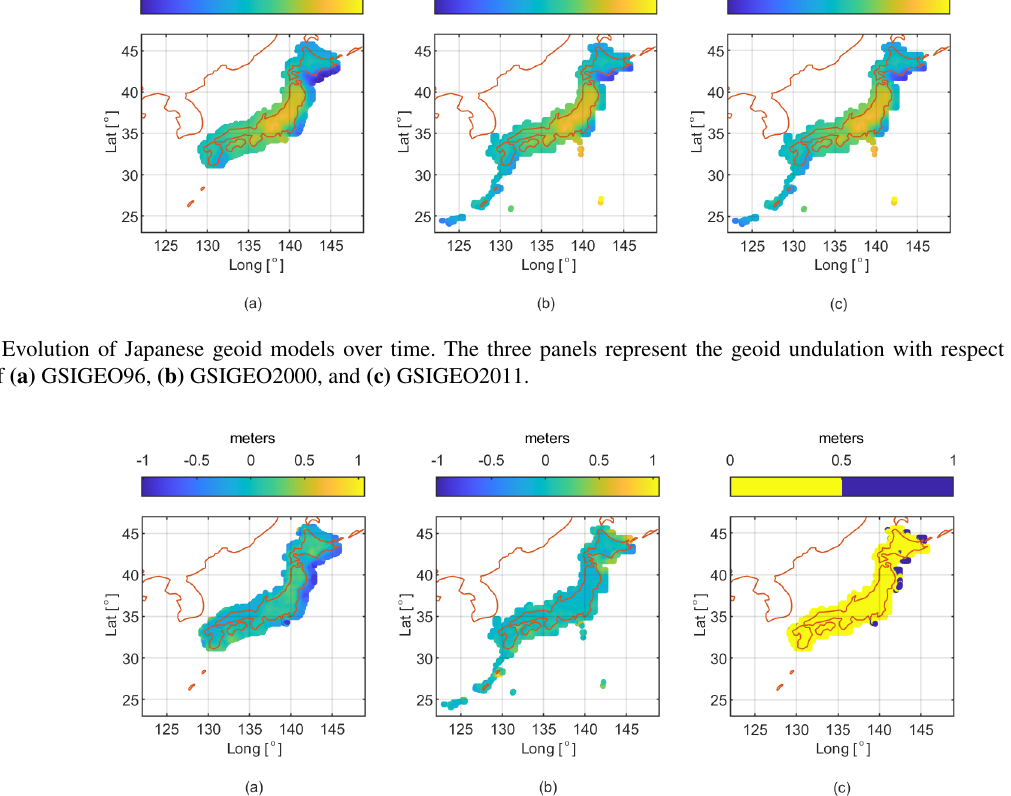
Figure 7. Difference between the analysed Japanese geoids. (a) GSIGEO96–GSIGEO2000; (b) GSIGEO2000–GSIGEO2011; (c) combined agreement between the considered Japanese geoids. In yellow areas the difference between GSIGEO96–00 and GSIGEO00–11 is less than 50cm, while in blue areas it is more than